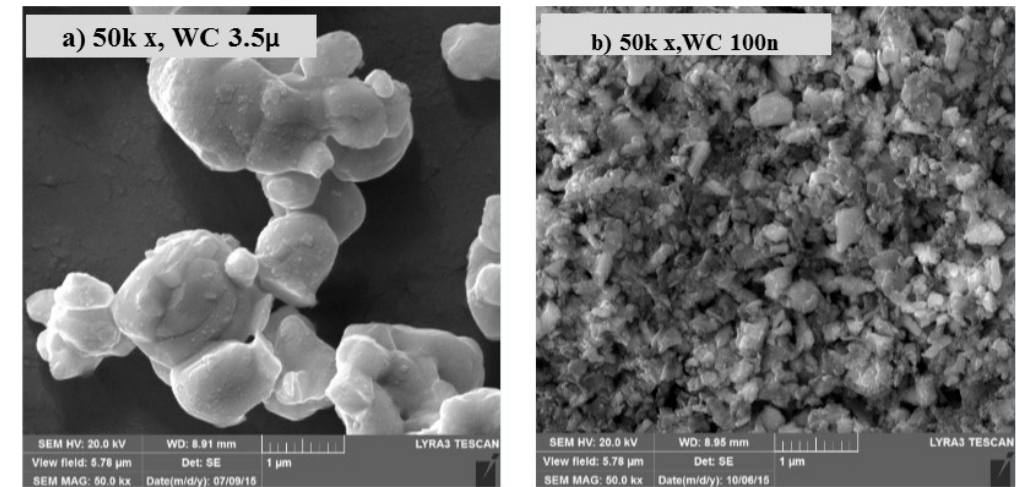
Figure 1. ( a ) FESEM image of the starting powder of WC, ( b ) SEM image of milled WC reaching an average size of 100 nm.